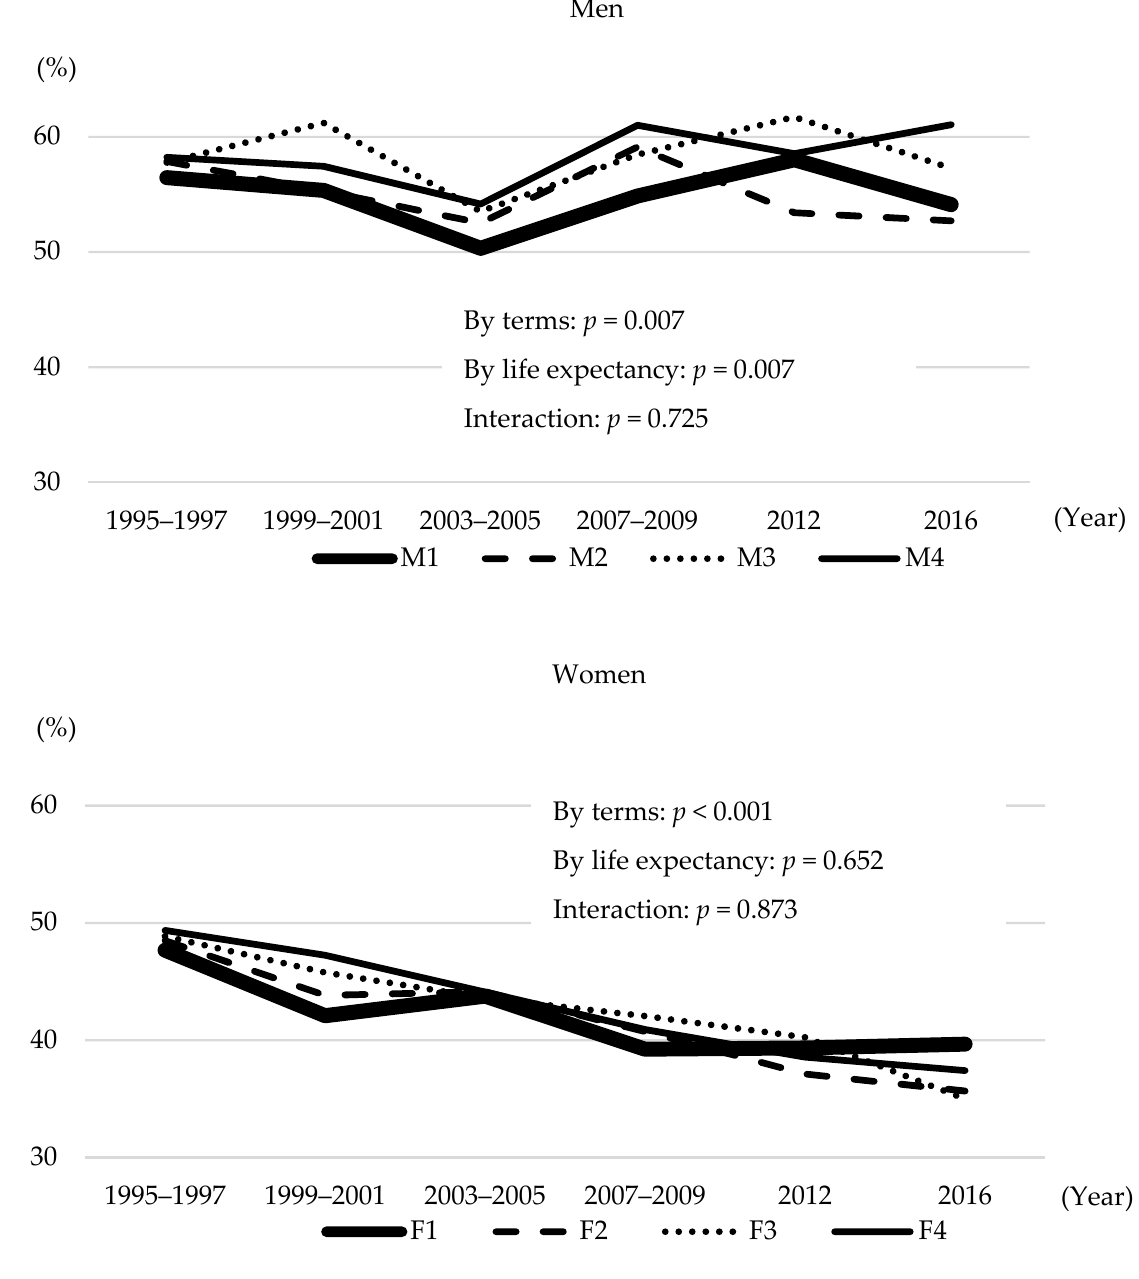
Figure 1. Prevalence of hypertension by four groups according to prefectural life expectancy. The age-standardised treatment rate of hypertension by terms increased among both men ( p < 0.001) and women ( p = 0.005) (Figure 2). The age-standardised treatment rate of hypertension tended to be associated with life expectancy among men ( p = 0.073), with M1 remaining at a low value (24.8%, 29.3%, 25.1%, 38.8%, 34.7%, and 48.2% for M4 and 24.4%, 25.4%, 26.7%, 34.1%, 35.9%, and 42.5% for M1, respectively). However, no association was found among women ( p =